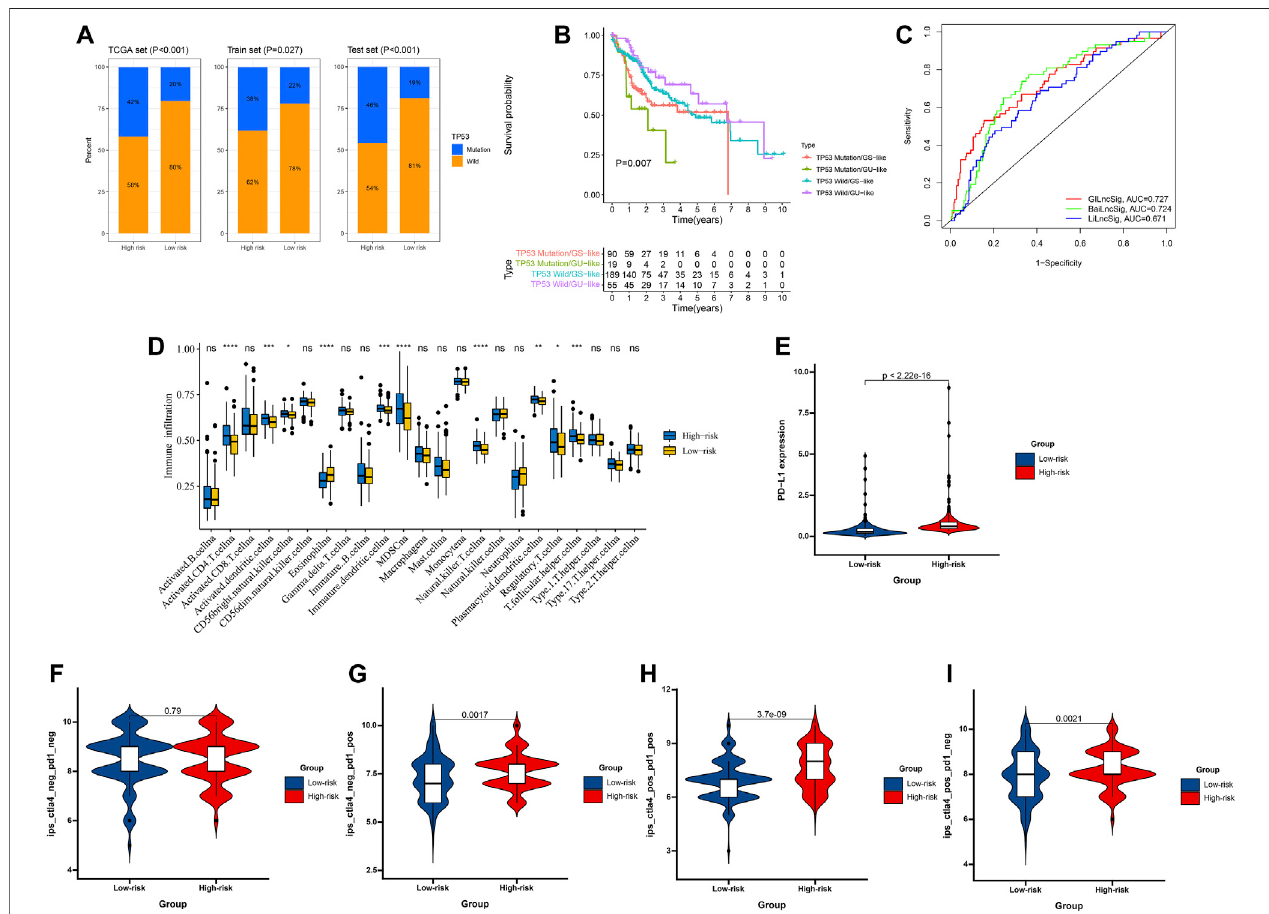
Statisticalanalysiswasperformedusingthelog-ranktest. (C) TheROCanalysisat3 yearsofoverallsurvivalfortheGILncSig,LilncSig,andBailncSig. (D) Theabundance of each TME in fi ltrating cell in high-risk and low-risk groups. The upper and lower ends of the boxes represented the interquartile range of values. The lines in the boxesrepresentedmedianvalue,andblackdotsshowedoutliers.Theasterisksrepresentedthestatistical p value. (E) PD-L1expressionpatternsforpatientsinhigh-risk andlow-riskgroupsintheTCGAcohort.ThecorrelationofGILncSigscorewithclinicalresponsetoanti-PD-1immunotherapy. (F) CTLA4_negative+PD-1_negative,